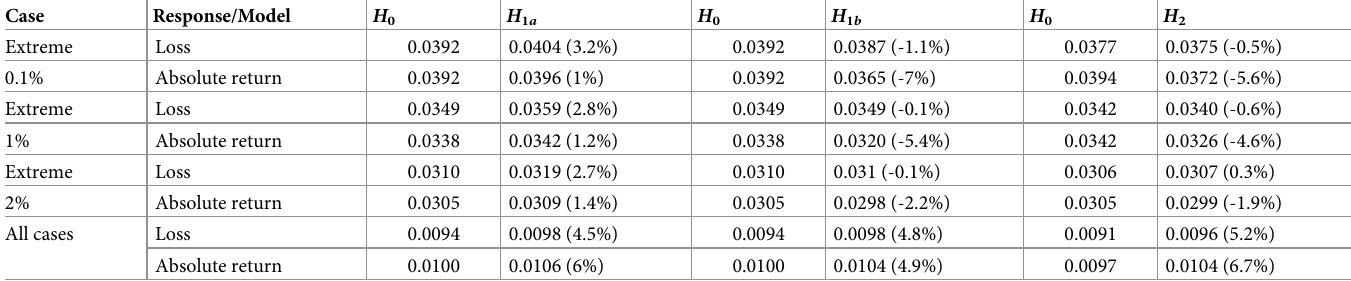
Table 2. RMSEs of the prediction using models Eq (9) and Eq (10) respectively of different hypotheses when considering tail events (Extreme 0.1%, 1% and 2%) and all cases. The rows indicate the responses (loss and absolute return). Each RMSE of the predictive models in H 1 a , H 1 b and H 2 is compared with the RMSE of the predictive model in H 0 , using respectively the same data with the sets of time indexes Q (99.9), Q (99) and Q (98). The values inside the brackets are the percentage differences of the RMSE of the model in